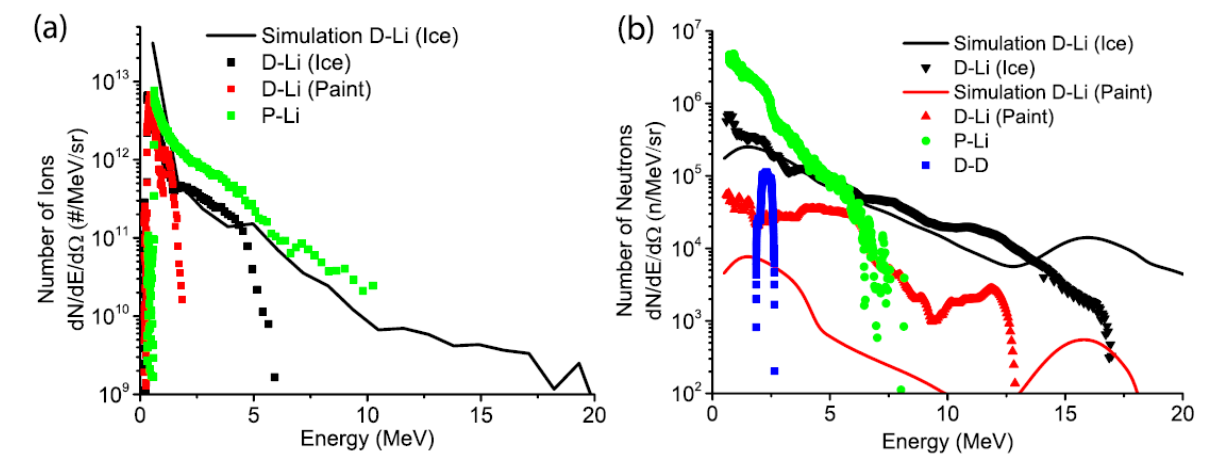
Figure 2. Experimental and simulated ion (a) and neutron (b) spectra along the target normal direction obtained by Zulick et al. in the 1,1 J and 300 TW HERCULES laser facility [4]. Figure 1. Target normal sheath acceleration graphic representation. Extracted from [3].